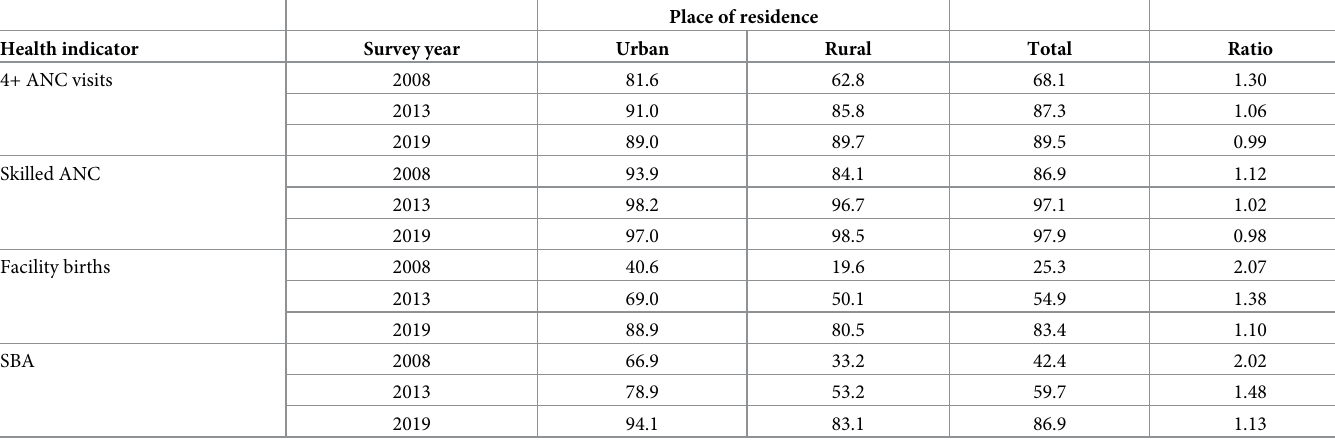
The wealth-based and maternal-education-based concentration indices show that there have been improvements (as shown by the decreasing levels over time) in inequality in the use of Table 4. Maternal health indicators by place of residence in 2008, 2013 and